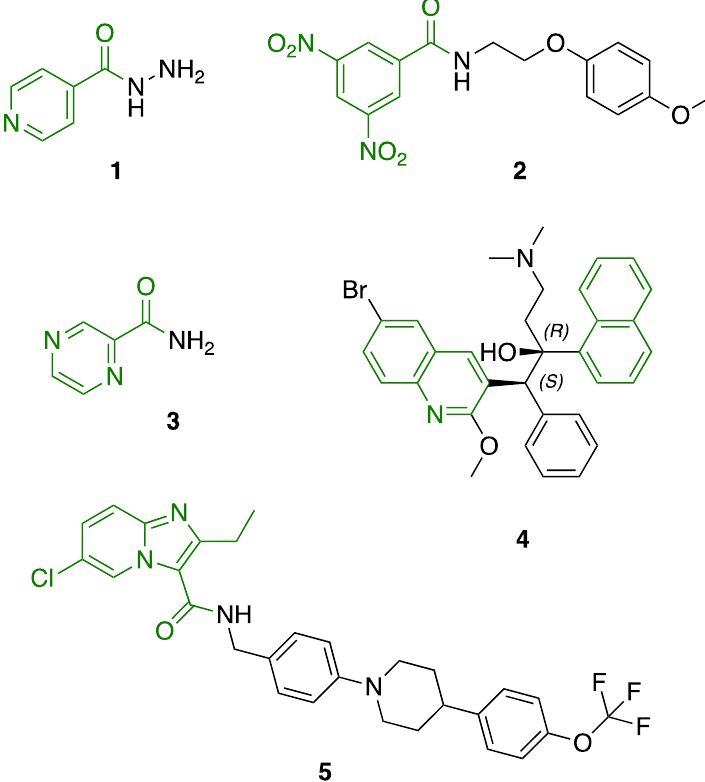
Figure 3. Scaffold hopping architectures (green) of molecules with known anti-tuberculosis (TB) activity evaluated within this study.